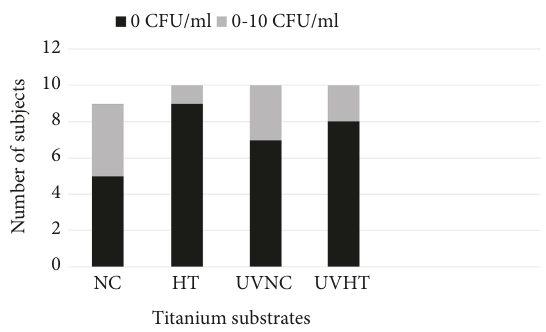
Figure 3: Number of subjects having no (0 CFU/ml) or low ( < 10 CFU)MScountsintheplaquecollectedfromthetitaniumalloysub- strates: Non-coated titanium alloy (NC), hydrothermally induced TiO 2 coating (HT), UV treated non-coated titanium alloy (UVNC) and UV treated titanium alloy with hydrothermally induced TiO 2 coating